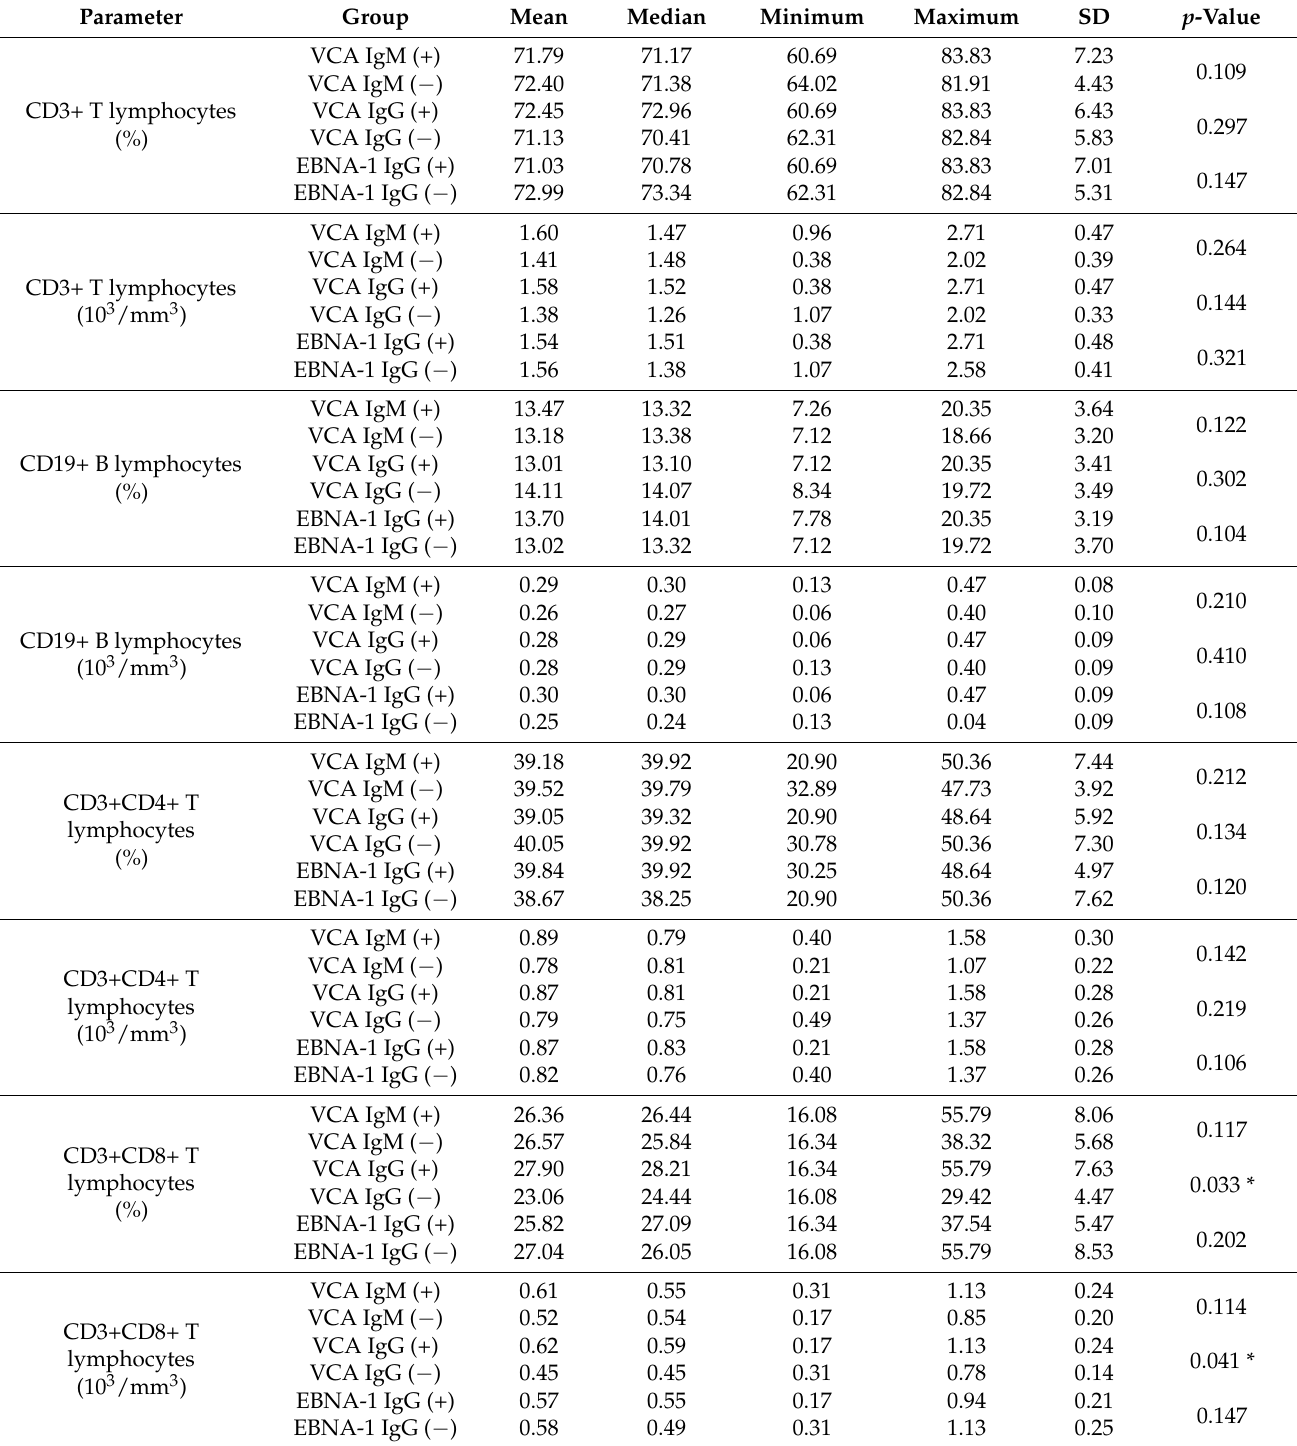
Table 5. Percentages and absolute values of selected subpopulations of lymphocytes in patients with type 1 diabetes depending on the presence of anti-VCA antibodies in the IgM and IgG class and anti-EBNA-1 in the IgG